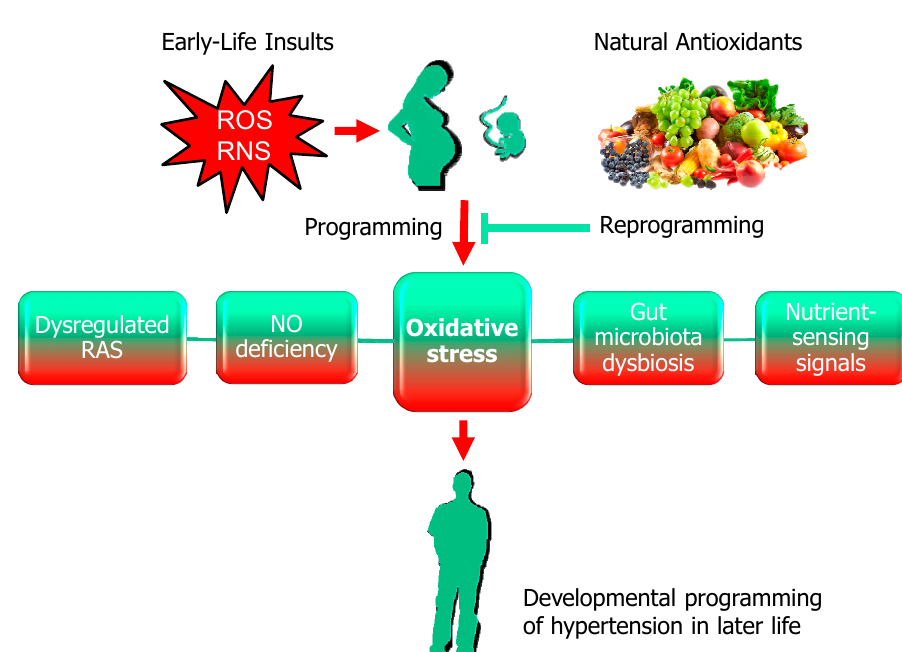
Figure 2. Schematic illustration of the impact of oxidative stress and natural antioxidants on hypertension of developmental origin. Red arrow indicates early-life insults in pregnancy causes increased reactive oxygen species (ROS)/reactive nitrogen species (RNS) and fetal programming, consequently resulting in hypertension in adult offspring. Oxidative stress acts as a central hub through which mechanisms contributing to programming hypertension are interconnected. These mechanisms include dysregulated the renin-angiotensin system (RAS), nitric oxide (NO) deficiency, gut microbiota dysbiosis, and impaired nutrient-sensing signals. Conversely, natural antioxidants can serve as reprogramming strategies to reverse the programmed processes and prevent the developmental programming of hypertension, which is indicated by green T-bar lines.